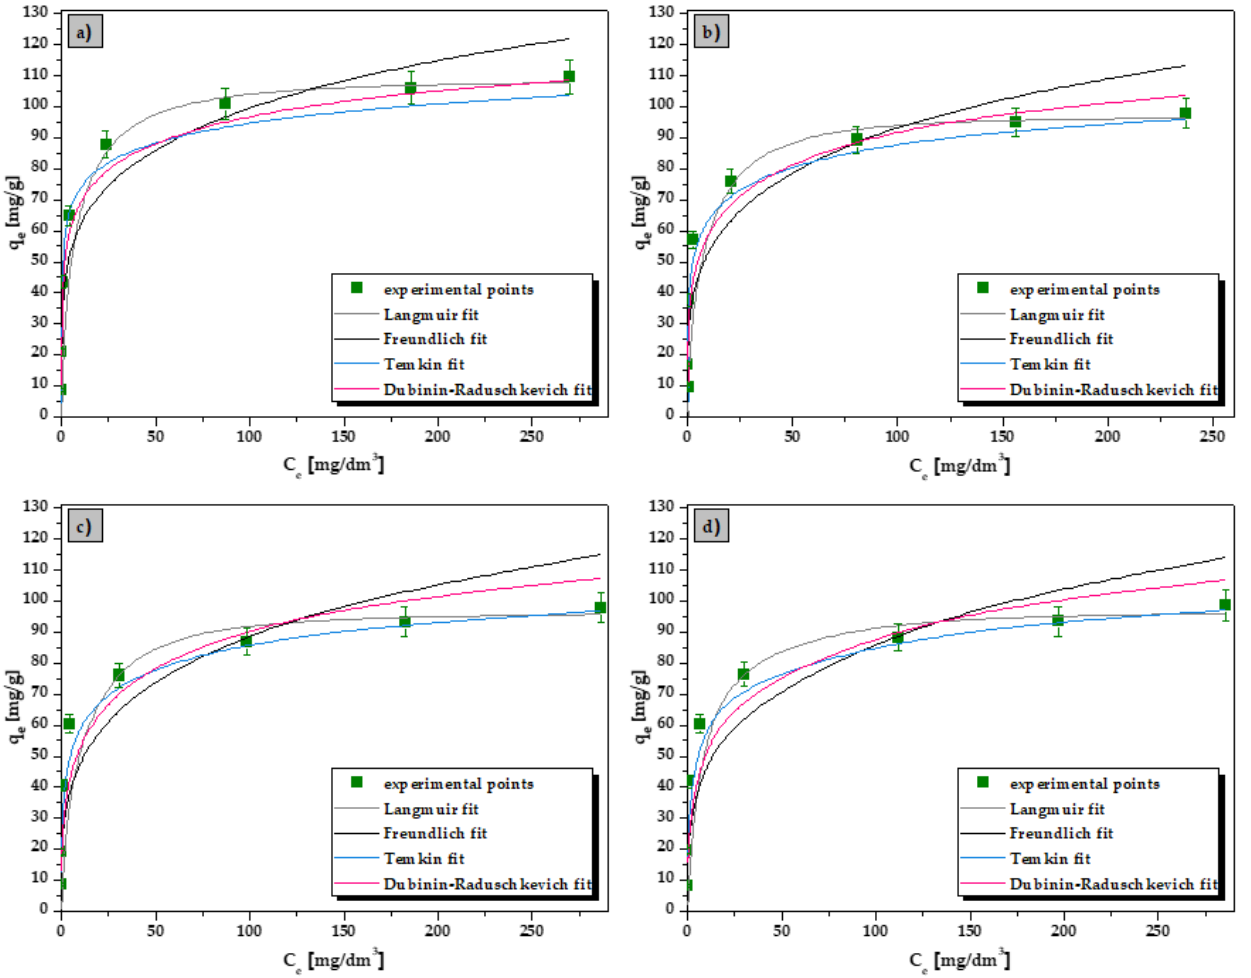
Figure 7. Nonlinear fitting of the isotherm models for ( a ) La(III), ( b ) Ce(III), ( c ) Pr(III), and ( d ) Nd(III) ions sorption on the ALG 5 L 1 composite at 333 K (conditions: C 0 = 25–500 mg/dm 3 , pH = 5, V = 20 cm 3 , m = 0.05 g, t = 1440 min).